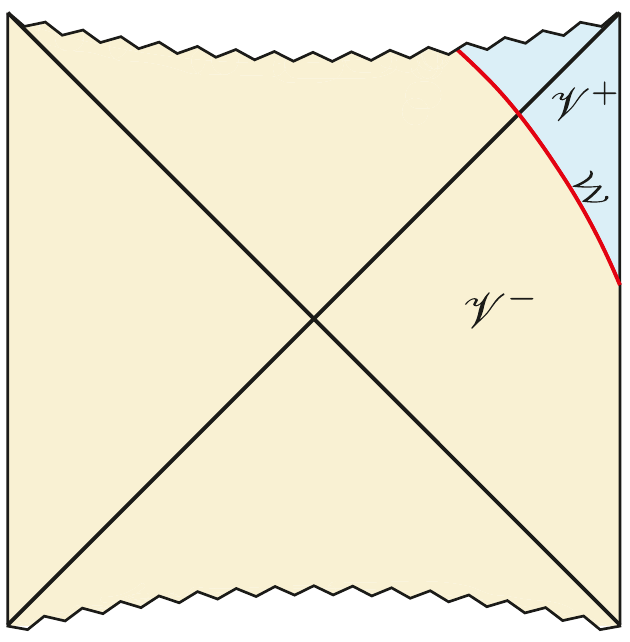
Figure 2 . Penrose diagram of the collapsing shell geometry. The shell is injected in the bulk at late times compared with T (cid:0) 1 , causing the initial black hole of mass M (cid:0) to grow up to the bigger mass M + . The worldvolume of the matter shell is labelled W and sets the boundary between the two black hole spacetimes V (cid:6)